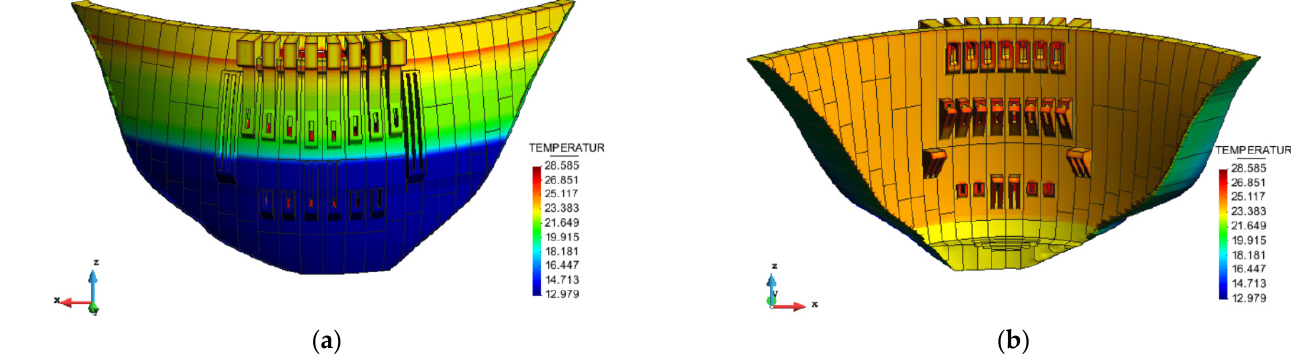
Figure 17. Cloud map of quasi-stable temperature field distribution of the dam in August (Unit: °C). ( a ) Upstream face; ( b ) Downstream surface.